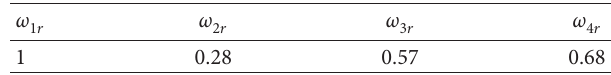
Table 7: Relative weights.